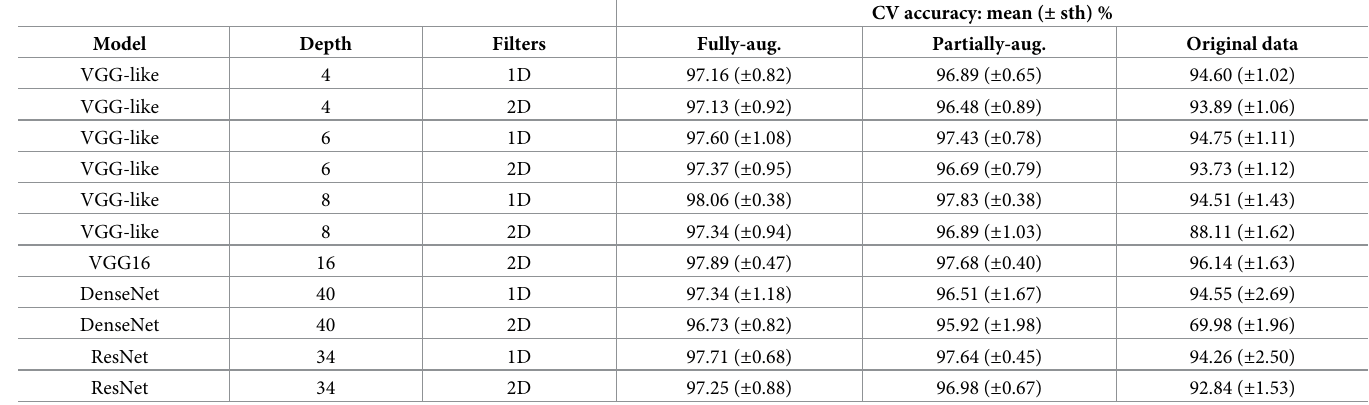
Table 2. Five-fold cross-validation (CV) performance achieved by tested CNN models on the VOC dataset. (Model VGG16 with 1D filters has not been tested due to its extensive demand for memory